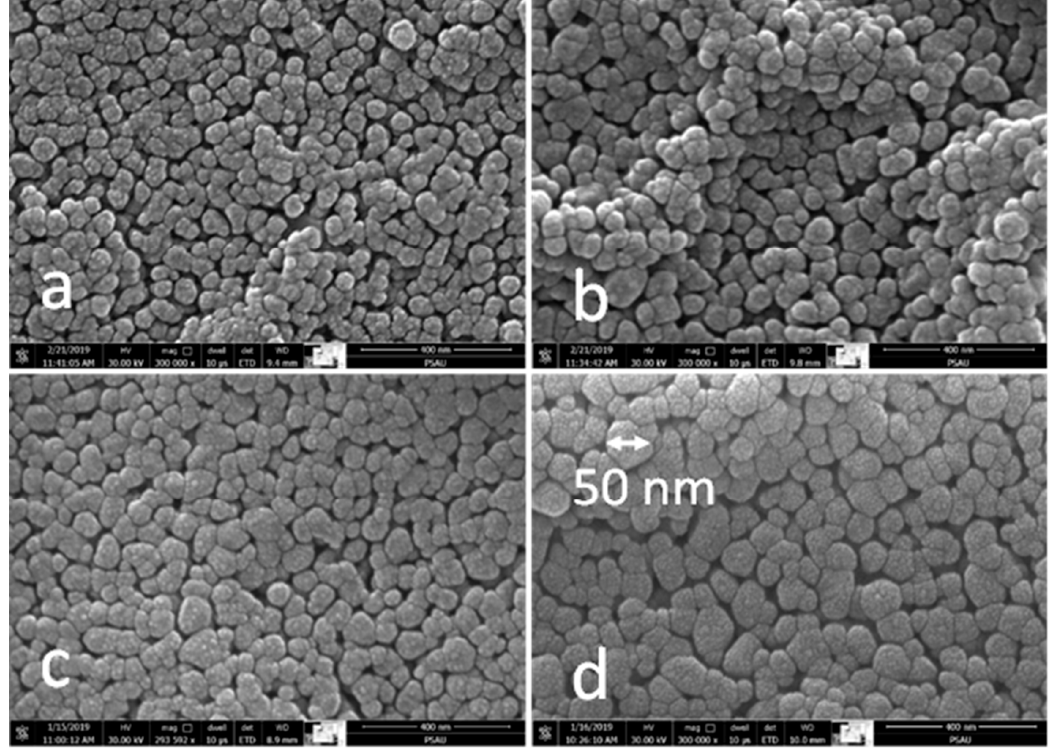
Figure 5. SEM images of ( a , b ) 0.5 M film, with and without wrinkles, and ( c , d ) 1 M film, with and without wrinkles.